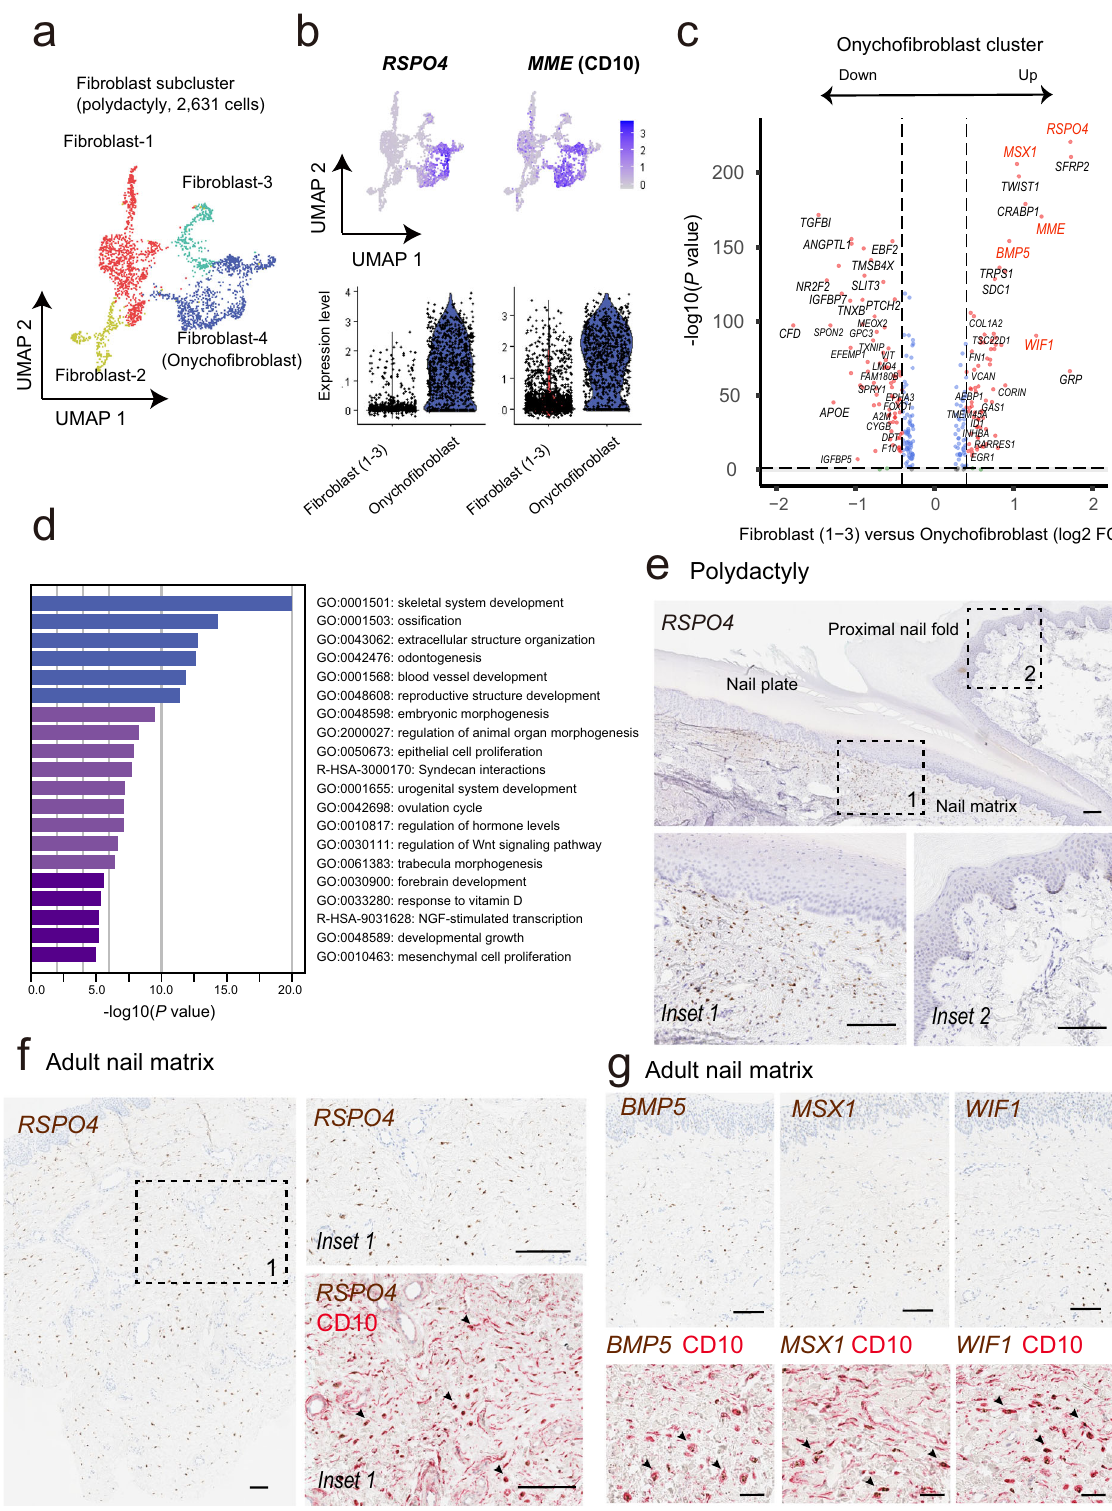
inhibitor in keratinocyte differentiation, SPINK6 might have a role in maintaining epithelial barrier in the nail unit 17 . Since con fi rmed a speci fi cally higher expression of SPINK6 in